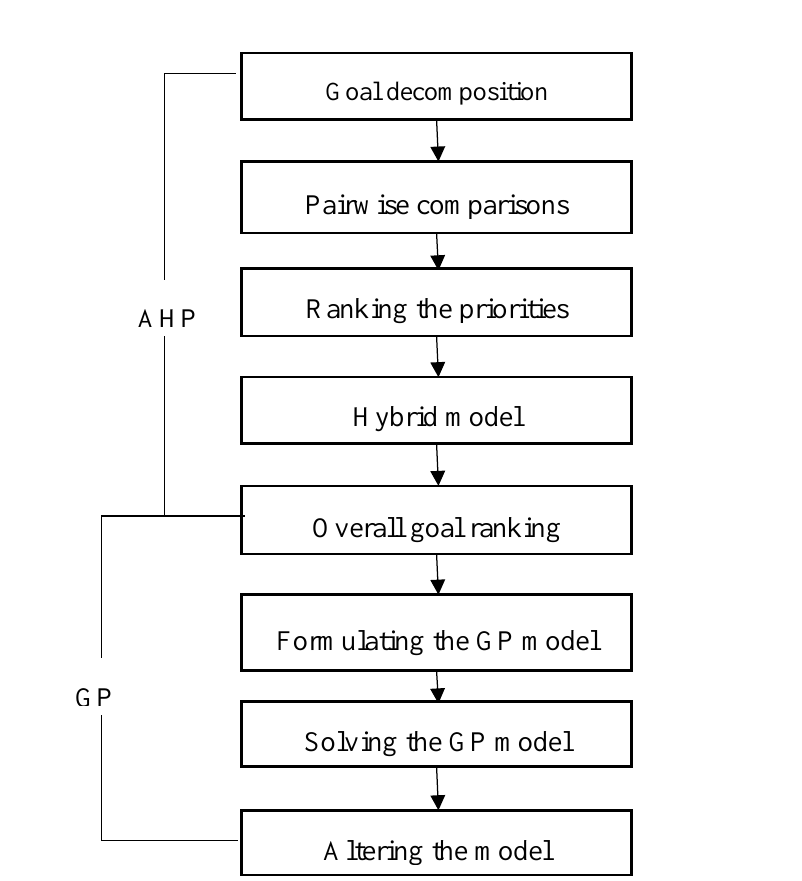
Figure 4. Integrated decision-making process ( Source: Mehregan, 2007: 290